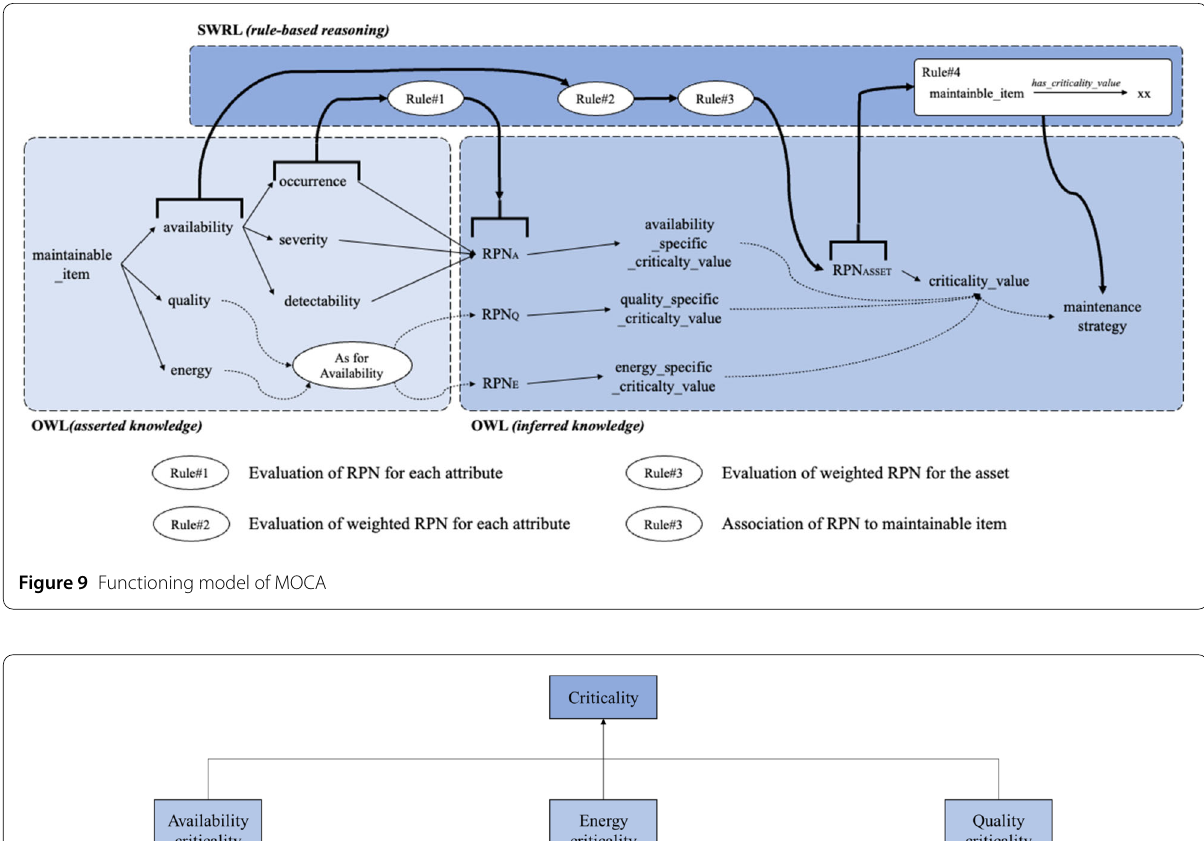
Figure 10 General scheme of the three-attribute criticality analysis for the food